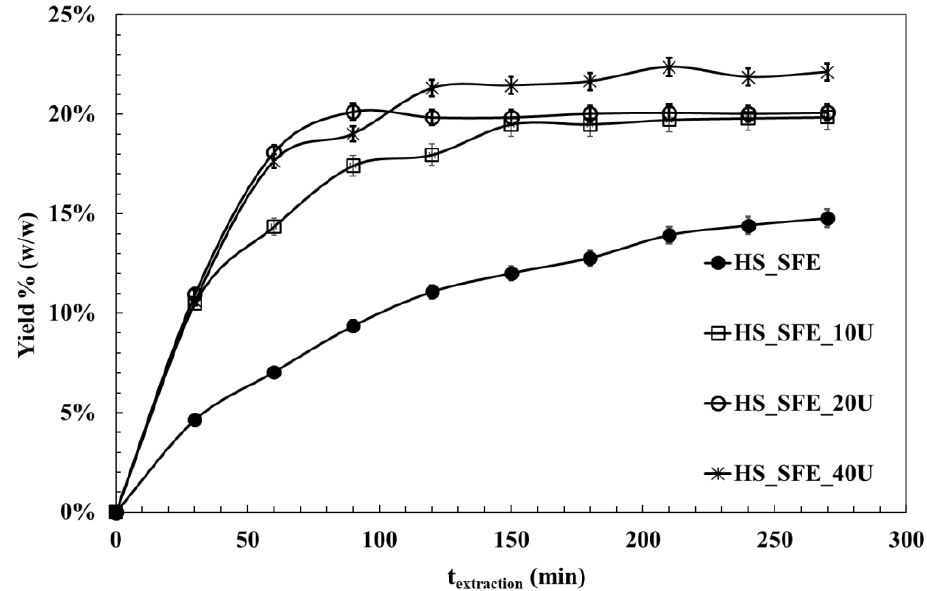
Figure 1. Yield (% w / w ) of oil extracted by supercritical CO 2 from untreated and ultrasound pre- treated seeds.